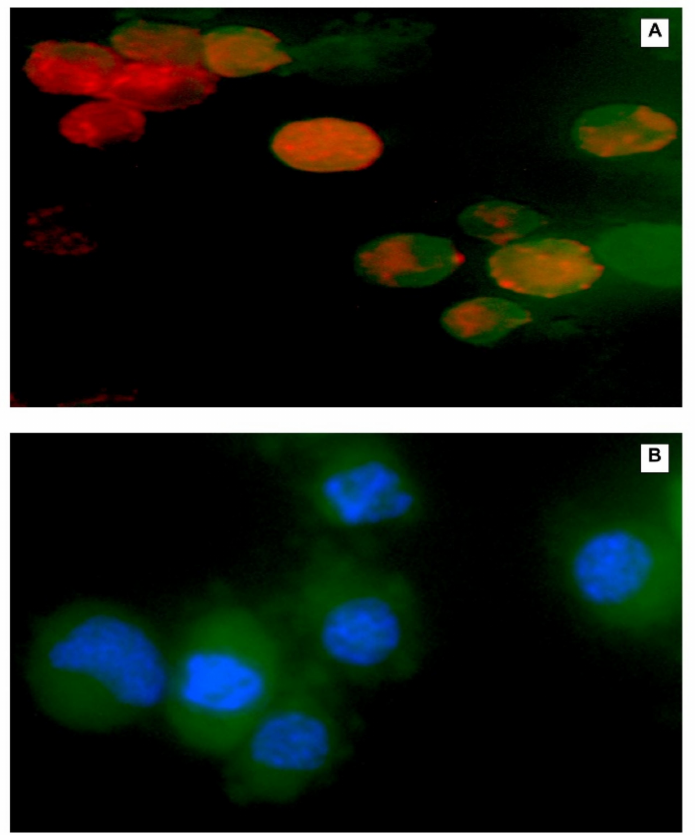
Figure 7. Fluorescence microscopy showing CL interacting with the cellular membrane. Fluorescent CL liposomal formulation with DNR ( A ), and fluorescent CL liposomal formulation with DAPI staining ( B ). Red color represents uptake of doxorubicin in cells. Blue color represents nuclei of cells stained with DAPI while green color represents fluorescent CL entry into